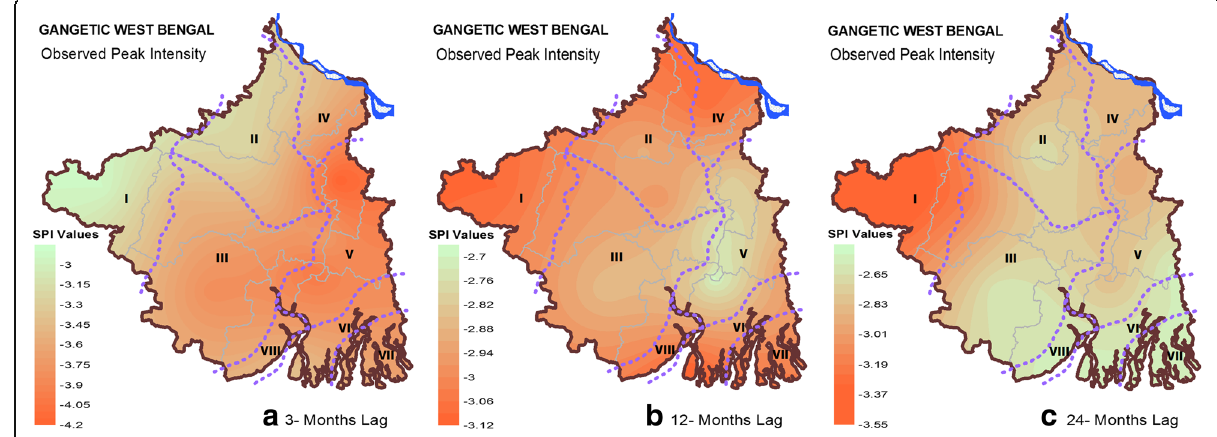
Fig. 5 Observed maximum intensity drought map at ( a ) 3-months ( b ) 12-months ( c ) 24-months time